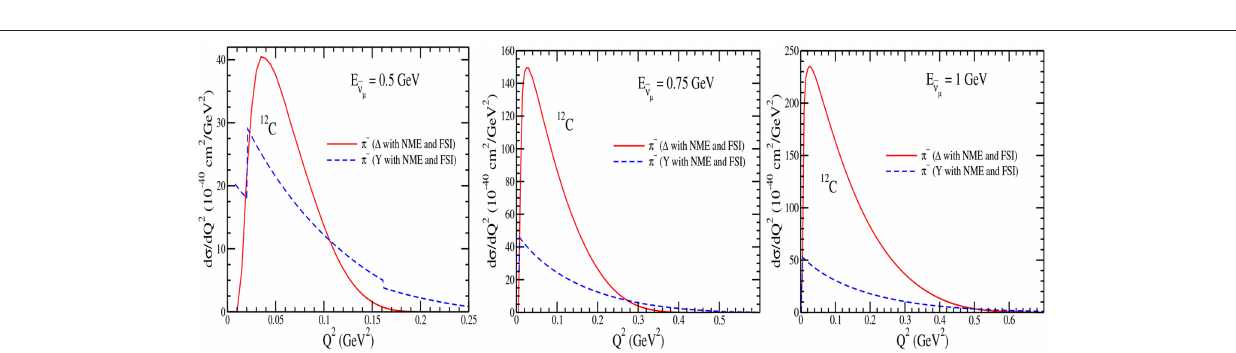
Frontiers in Physics |